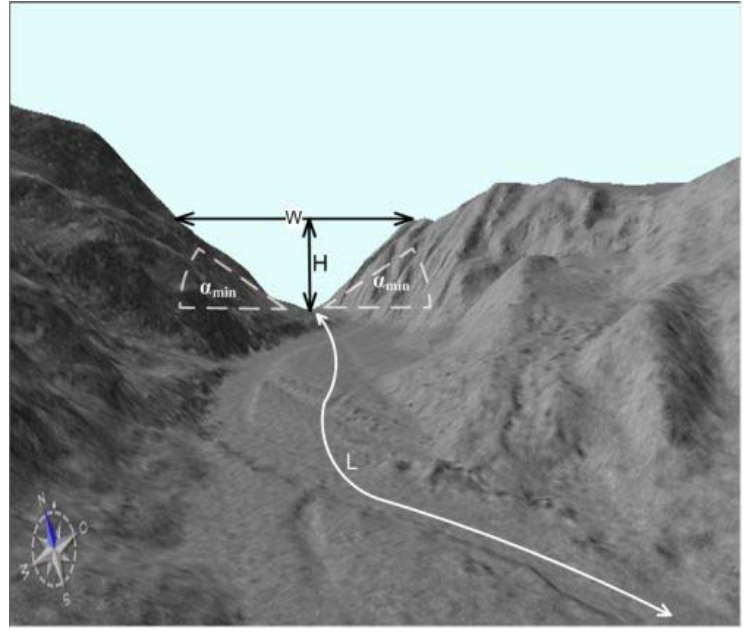
Figure 1. A characteristic cross-section of a canyon defined by the slope inclination α , depth H and width W. The white line is centreline of the canyon along which its length (L) is